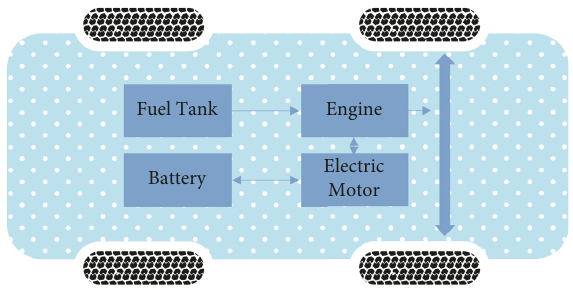
Figure 2: PHEV car